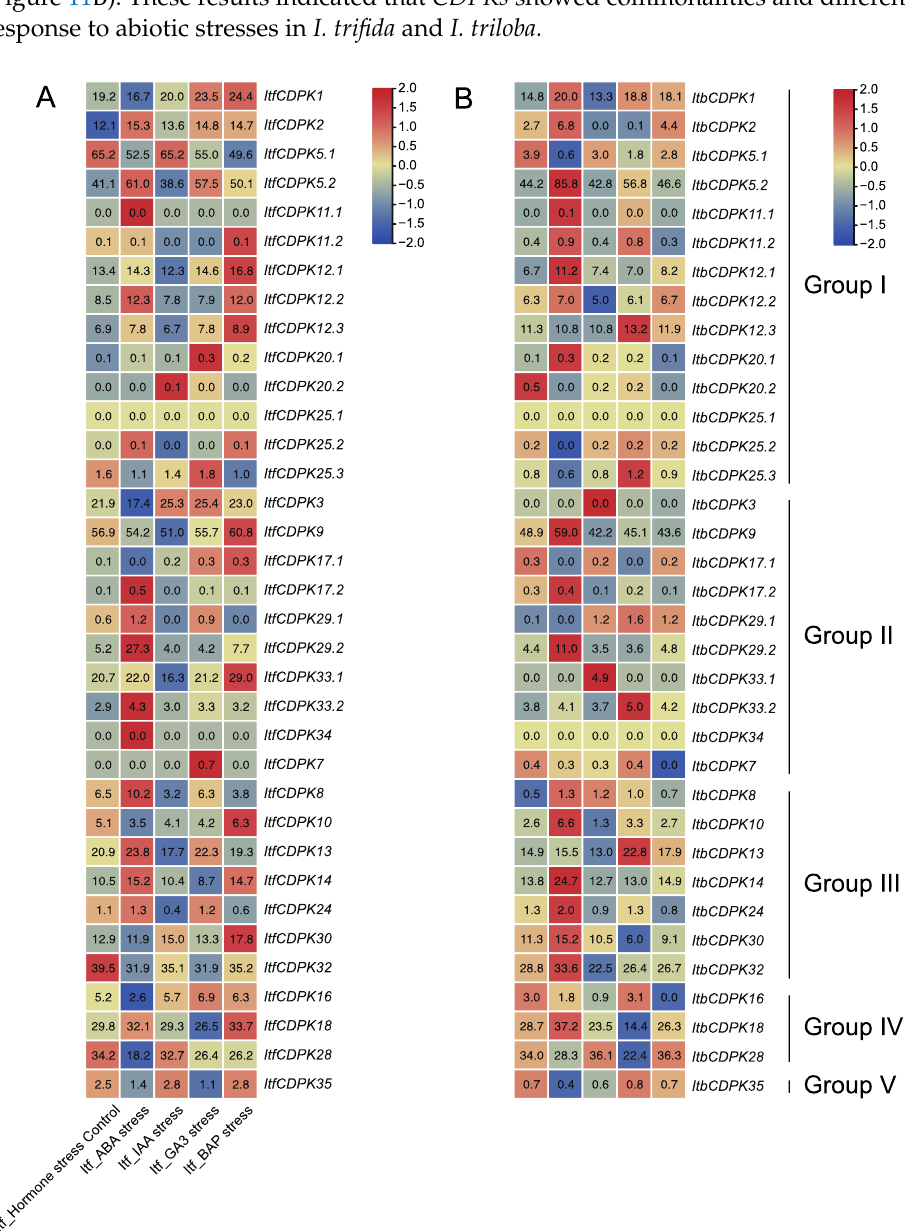
Figure 9. Gene expression patterns of ItfCDPKs ( A ) and ItbCDPKs ( B ) in response to different phytohormone (ABA, IAA, GA3, and BAP) in I. trifida and I. triloba as determined by RNA-seq. Log 2 (FPKM + 1) is shown in the